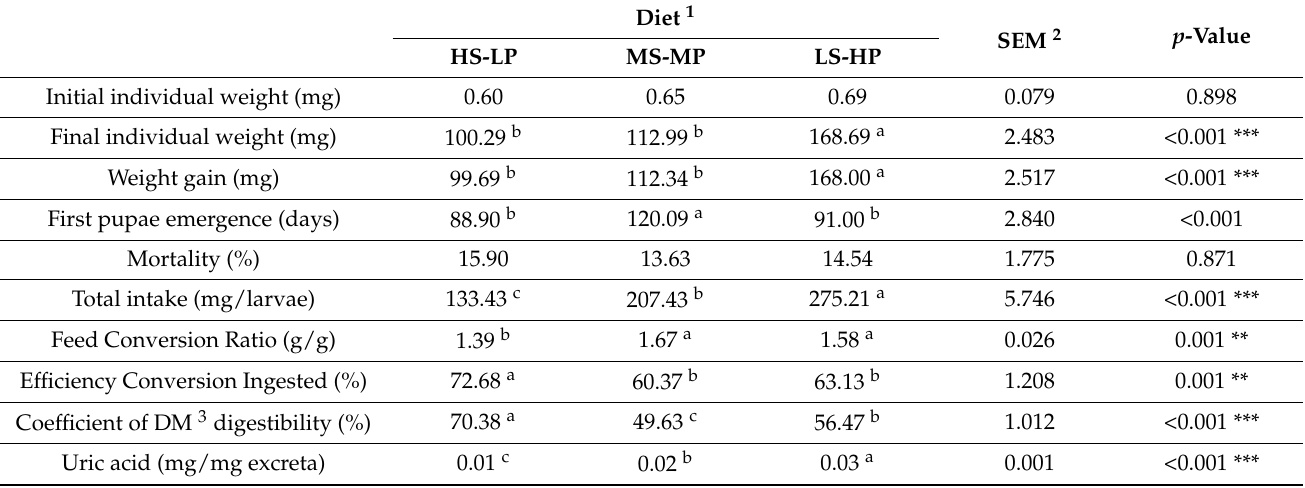
Table 3. Productive parameters, digestibility, and fecal uric acid levels of Tenebrio molitor larvae reared on by-product-based diets. Diet 1